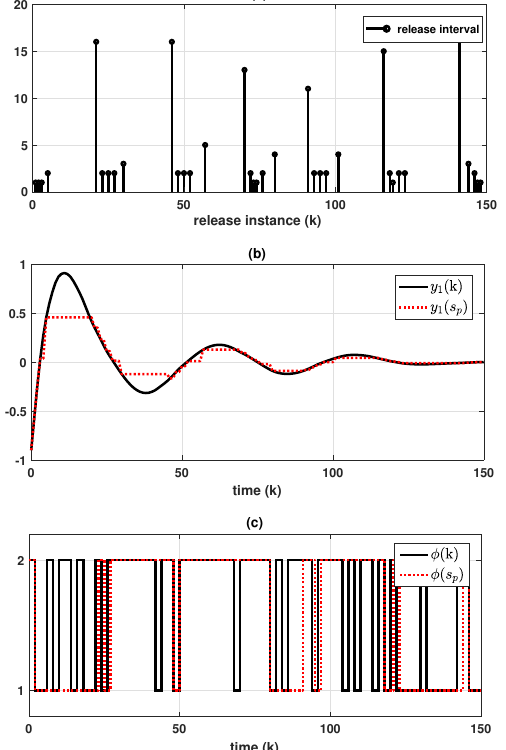
Figure 4. Event-triggered transmission: ( a ) the release instance and interval, ( b ) measured output y ( k ) and y ( s p ) , and ( c ) evolution of φ ( k ) and φ ( s p ) .